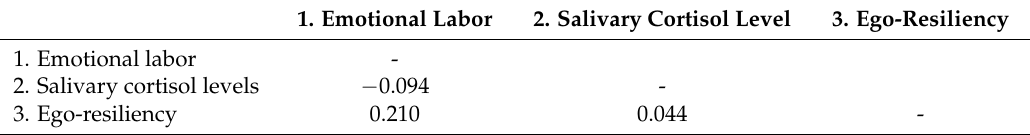
Table 3. Correlations between study